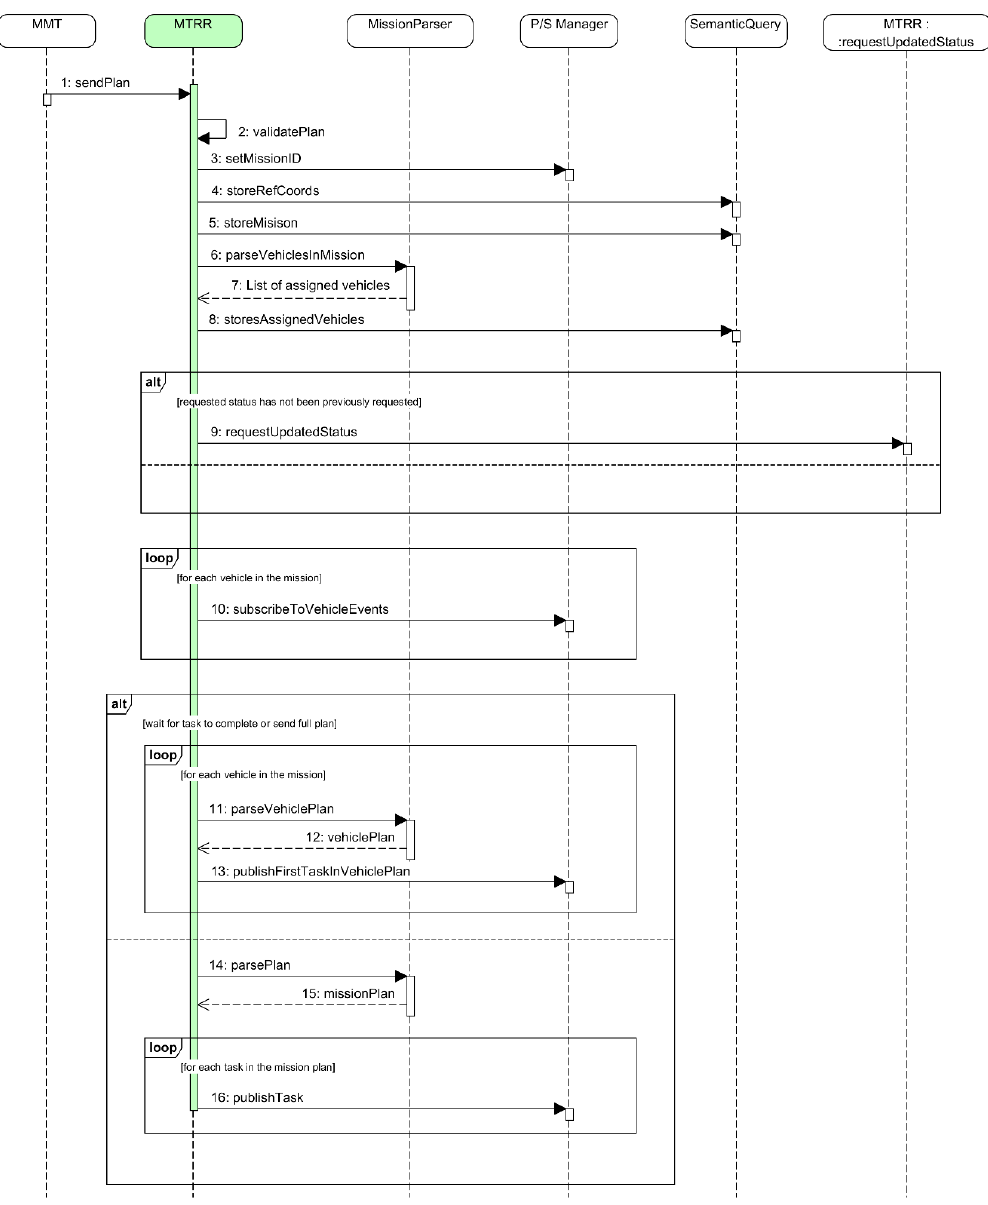
Figure 14. Sequence diagram for the startMission procedure performed by the MTRR .